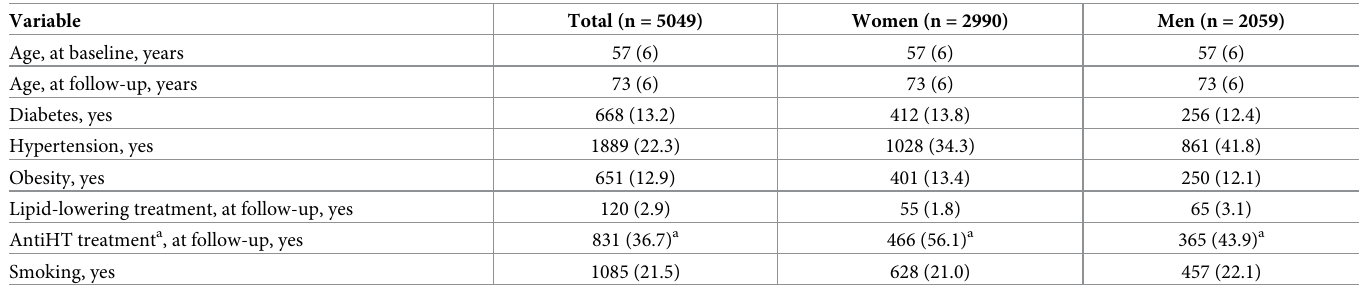
Table 1. Demographic characteristics of study